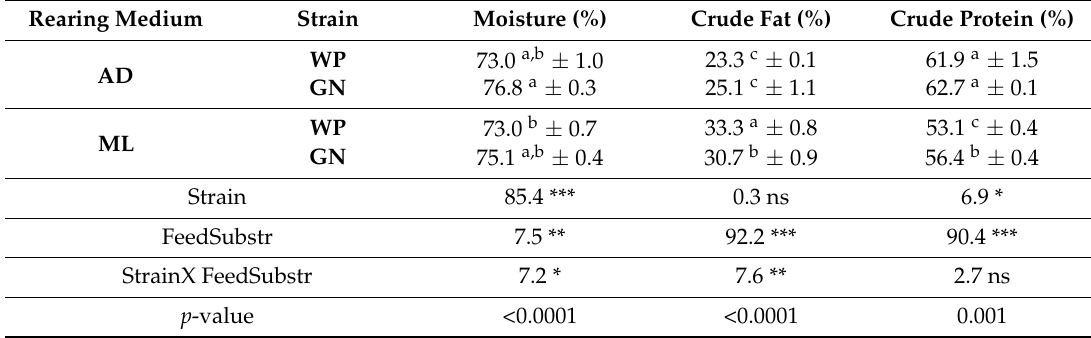
Table 2. Moisture, crude fat content, and crude protein content of the pupae of White Polyhybrid (WP) and Golden Nistari (GN) strains fed with an artificial diet (AD) and mulberry leaves